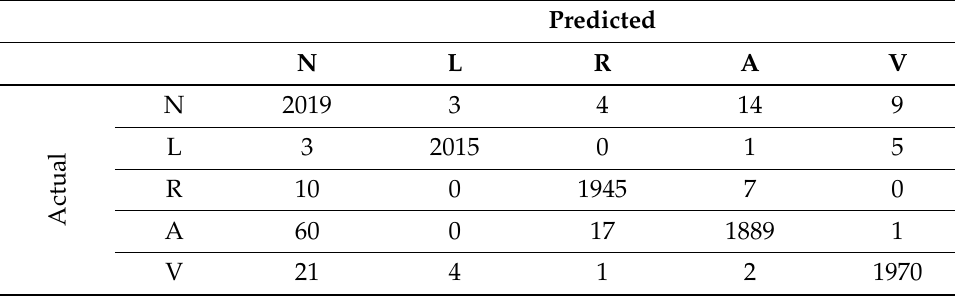
Table 13. Confusion Matrix of the Classified Arrhythmia